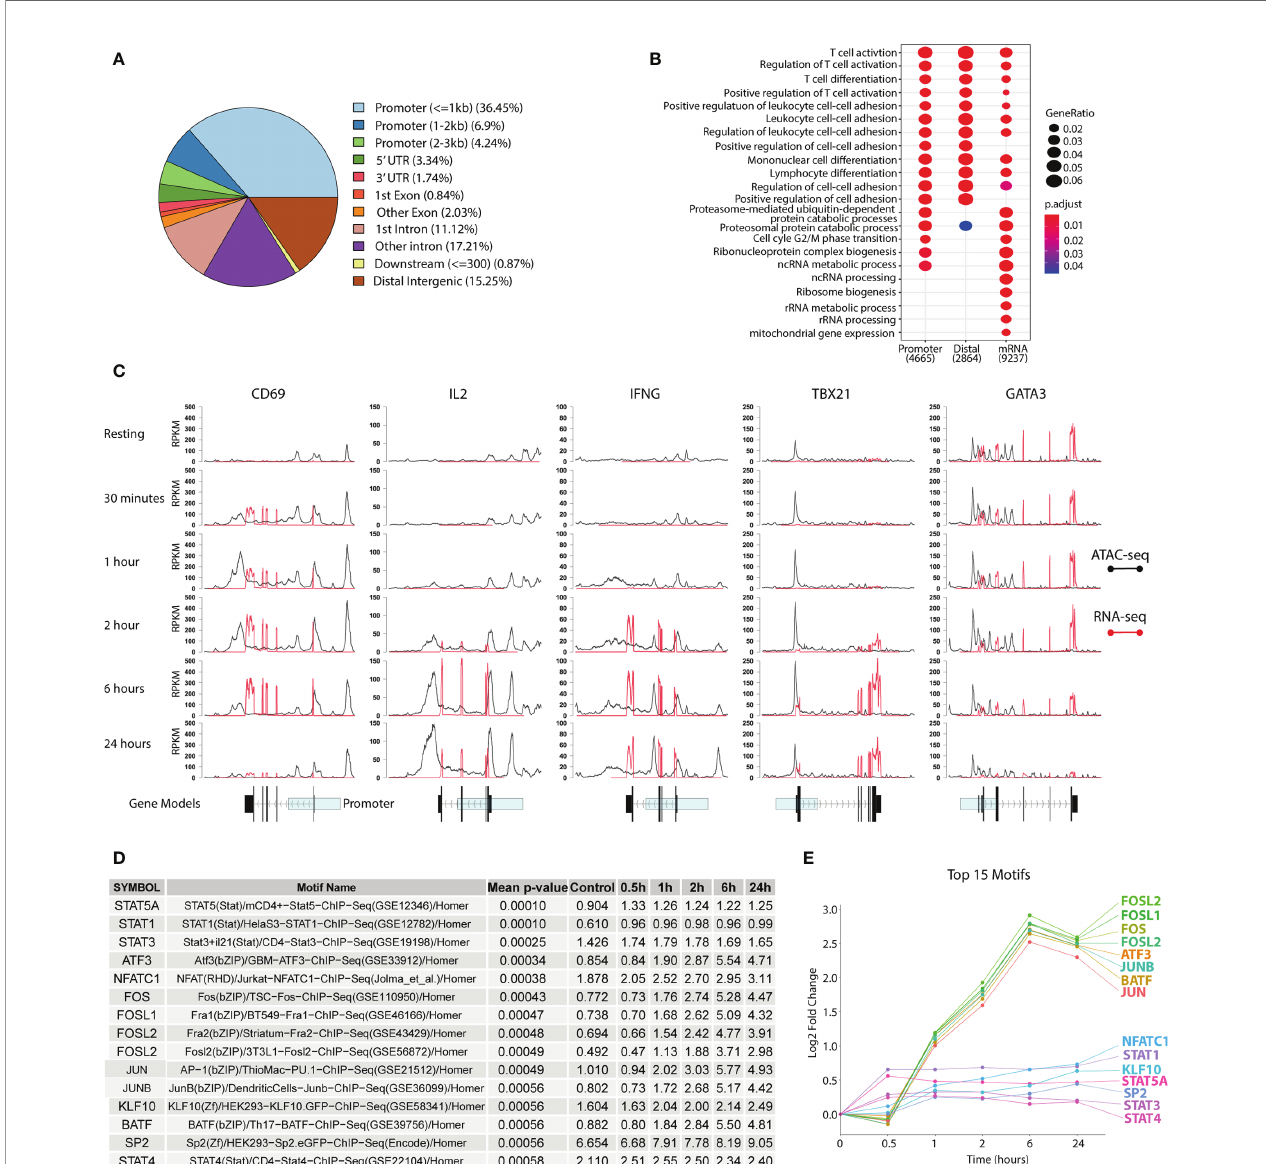
FIGURE 2 | Changes in the chromatin and transcriptomic landscape during T H 1 differentiation. Primary naïve human CD4 + T cells were activated and differentiated towards T H 1 using CD3/CD28 Dynabeads ™ , IL-12p70, IL-2 and anti-IL-4 antibodies. ATAC-seq and RNA-seq were used to assess chromatin and transcriptomic changes respectively. (A) Peak annotation to genomic elements based on the peaks from the ATAC-seq. (B) GO pathway enrichment of differentially accessible or expressed genes over the whole T H 1 time series. (C) Accessibility (black for ATAC-seq) and expression (red for RNA-seq) shown as RPKM for CD69 , IL2 , IFNG , TBX21 and GATA3 over time. Gene models of the genes with exons (black) and the promotor region (transparent blue) are displayed below. (D) Table of the top 15 most highly enriched motifs over the T H 1 time course with the percentage of total discovered motifs stated for each TF. Geometric mean of adjusted p-values over the whole time series are shown in the table. (E) Gain in percentage of total discovered motifs (compared to baseline) for the top 15 motifs presented as log 2 fold change over the time series. TF, transcription factor; T H 1, T helper 1 cells; RPKM, Reads per kilo base per million mapped